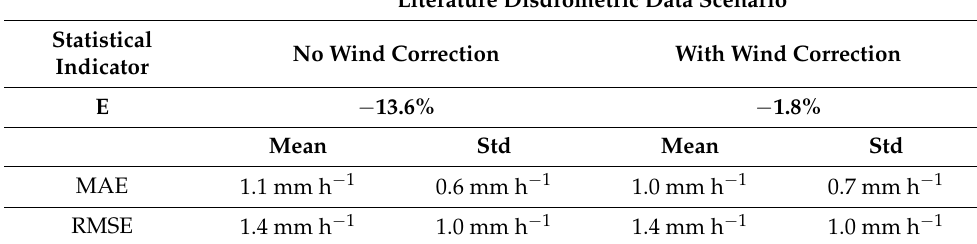
Table 5. For each statistical indicator, the mean and standard deviation (named Std for the sake of brevity) are listed for literature disdrometric data before and after the correction for wind effects. As in Table 2, these results are referred to the whole dataset.